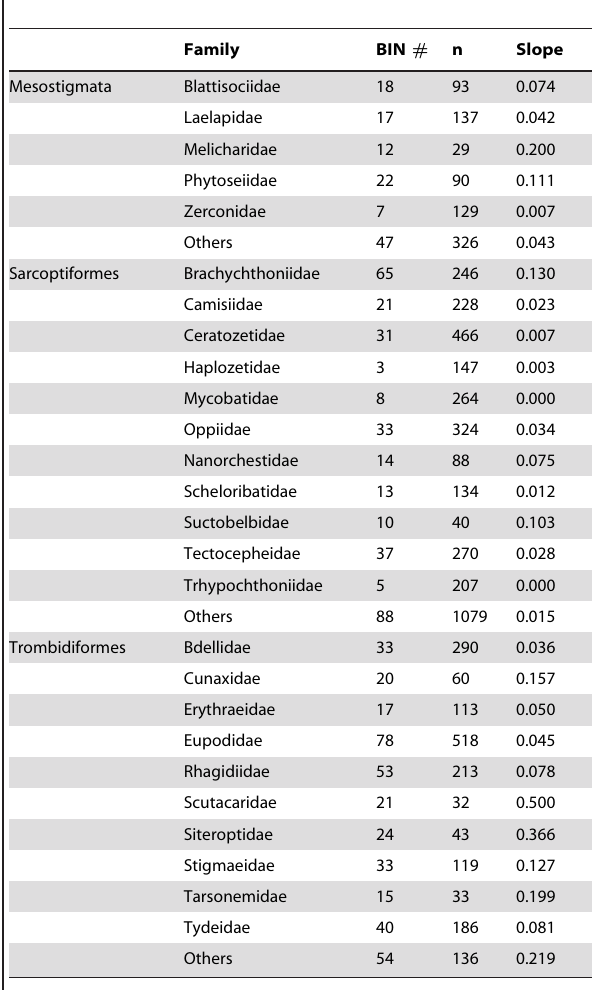
Table 2. Richness and terminal slope for the accumulation curve of selected families in three orders of Acari.